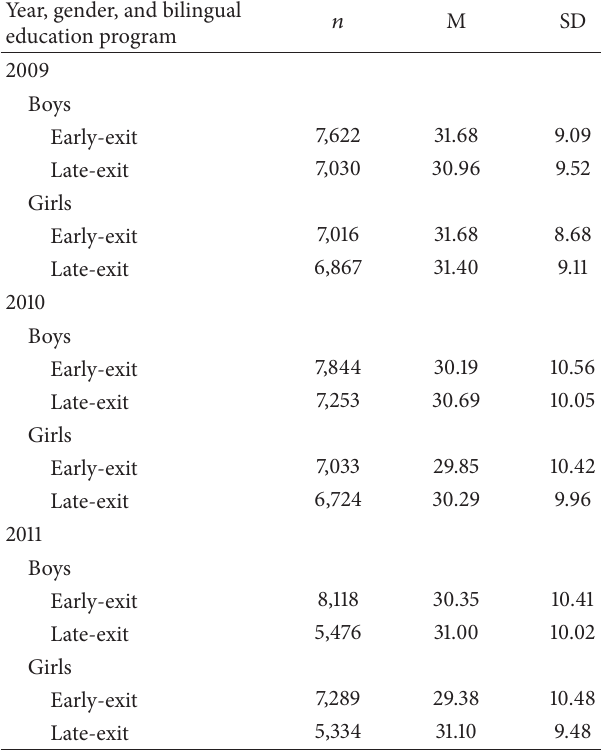
Table 7: Descriptive statistics for the 2009, 2010, and 2011